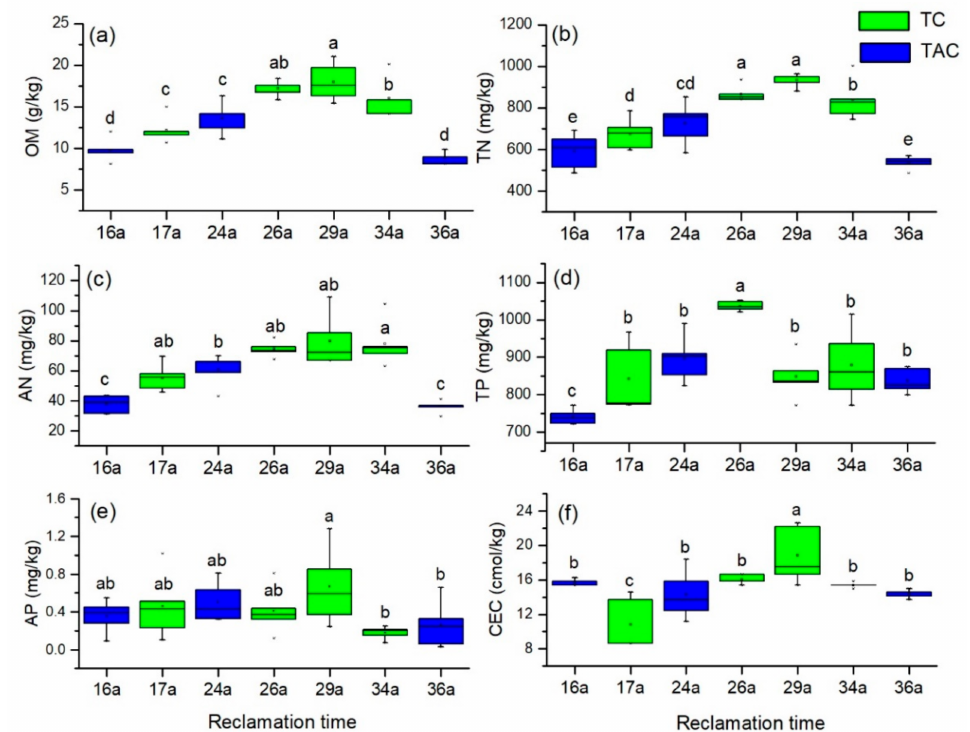
Figure 3. Soil organic matter (OM) ( a ), total nitrogen (TN) ( b ), alkaline hydrolyzable nitrogen (AN) ( c ), total phosphorus (TP) ( d ), available phosphorus (AP) ( e ), and cation exchange capacity (CEC) ( f ) in different reclamation zones. Values represent the means ± SDs. Different letters indicate significant differences among different reclamation years (LSD, p < 0.05). 16a, 17a, 24a, 26a, 29a, 34a and 36a indicate reclamation years of 16, 17, 24, 26, 29, 34 and 36, respectively.